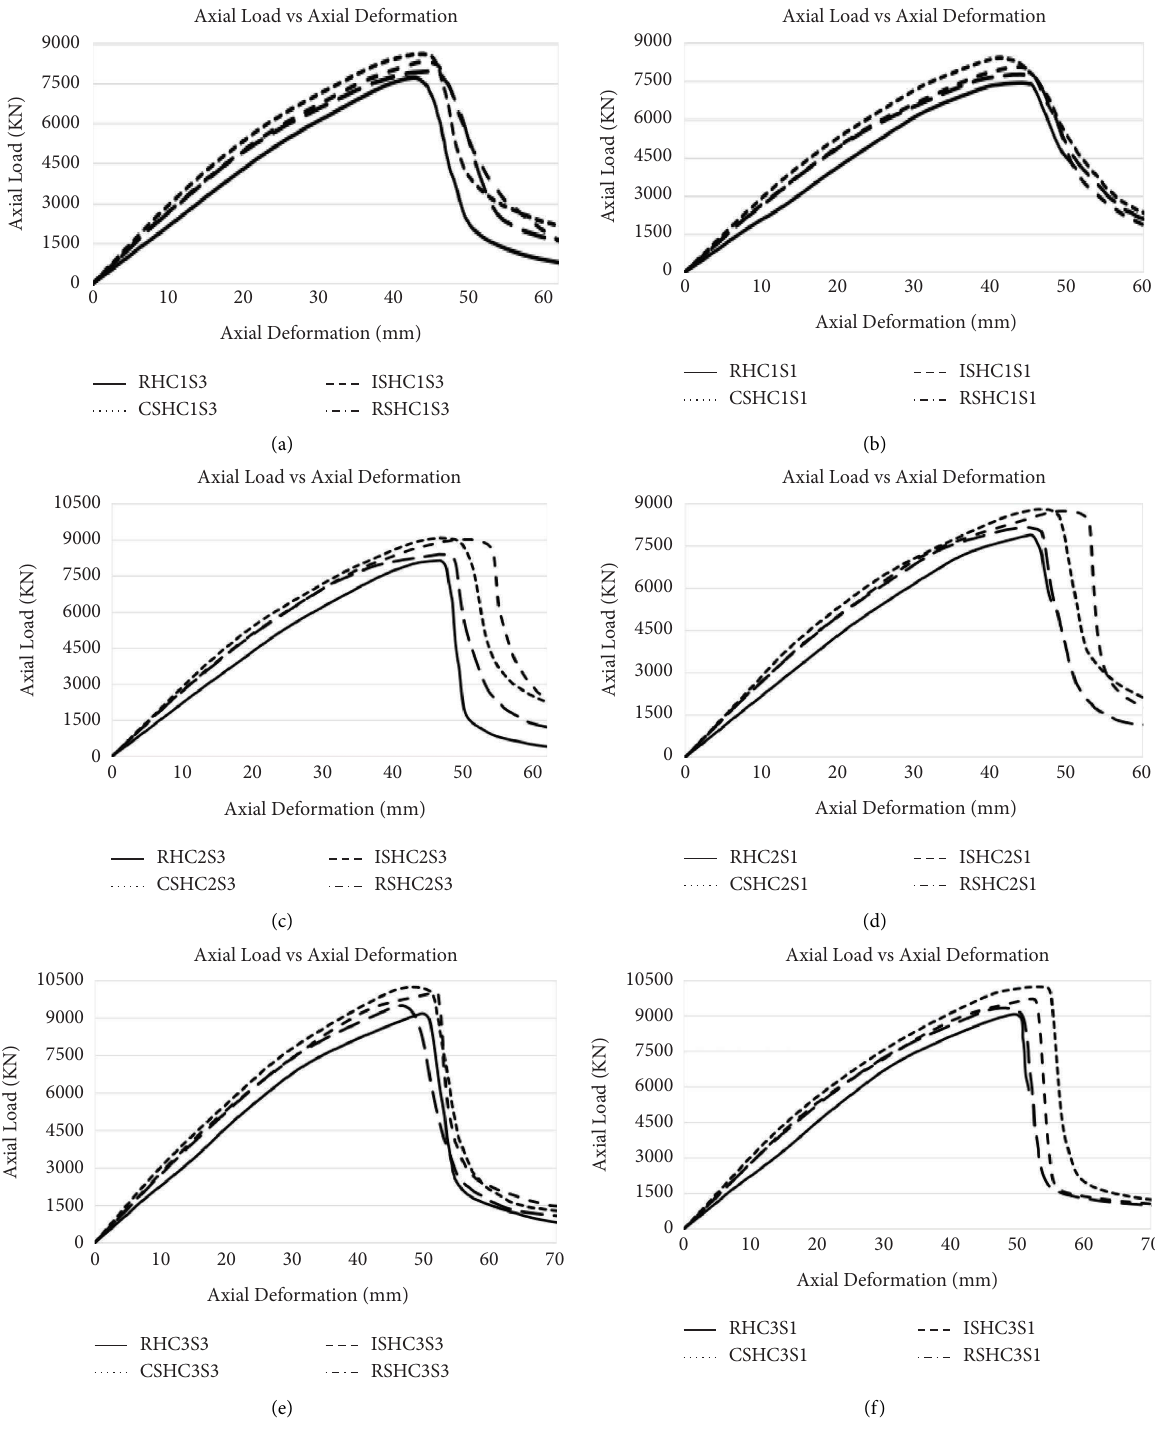
Figure 8: Efect of structural steel shape on load-deformation response: (a) group 1, s � 50 mm; (b) group 1, s � 100mm, (c) group 2, s � 50mm, (d) group 2, s � 100mm, (e) group 3, s � 50mm, and (f) group 3, s �